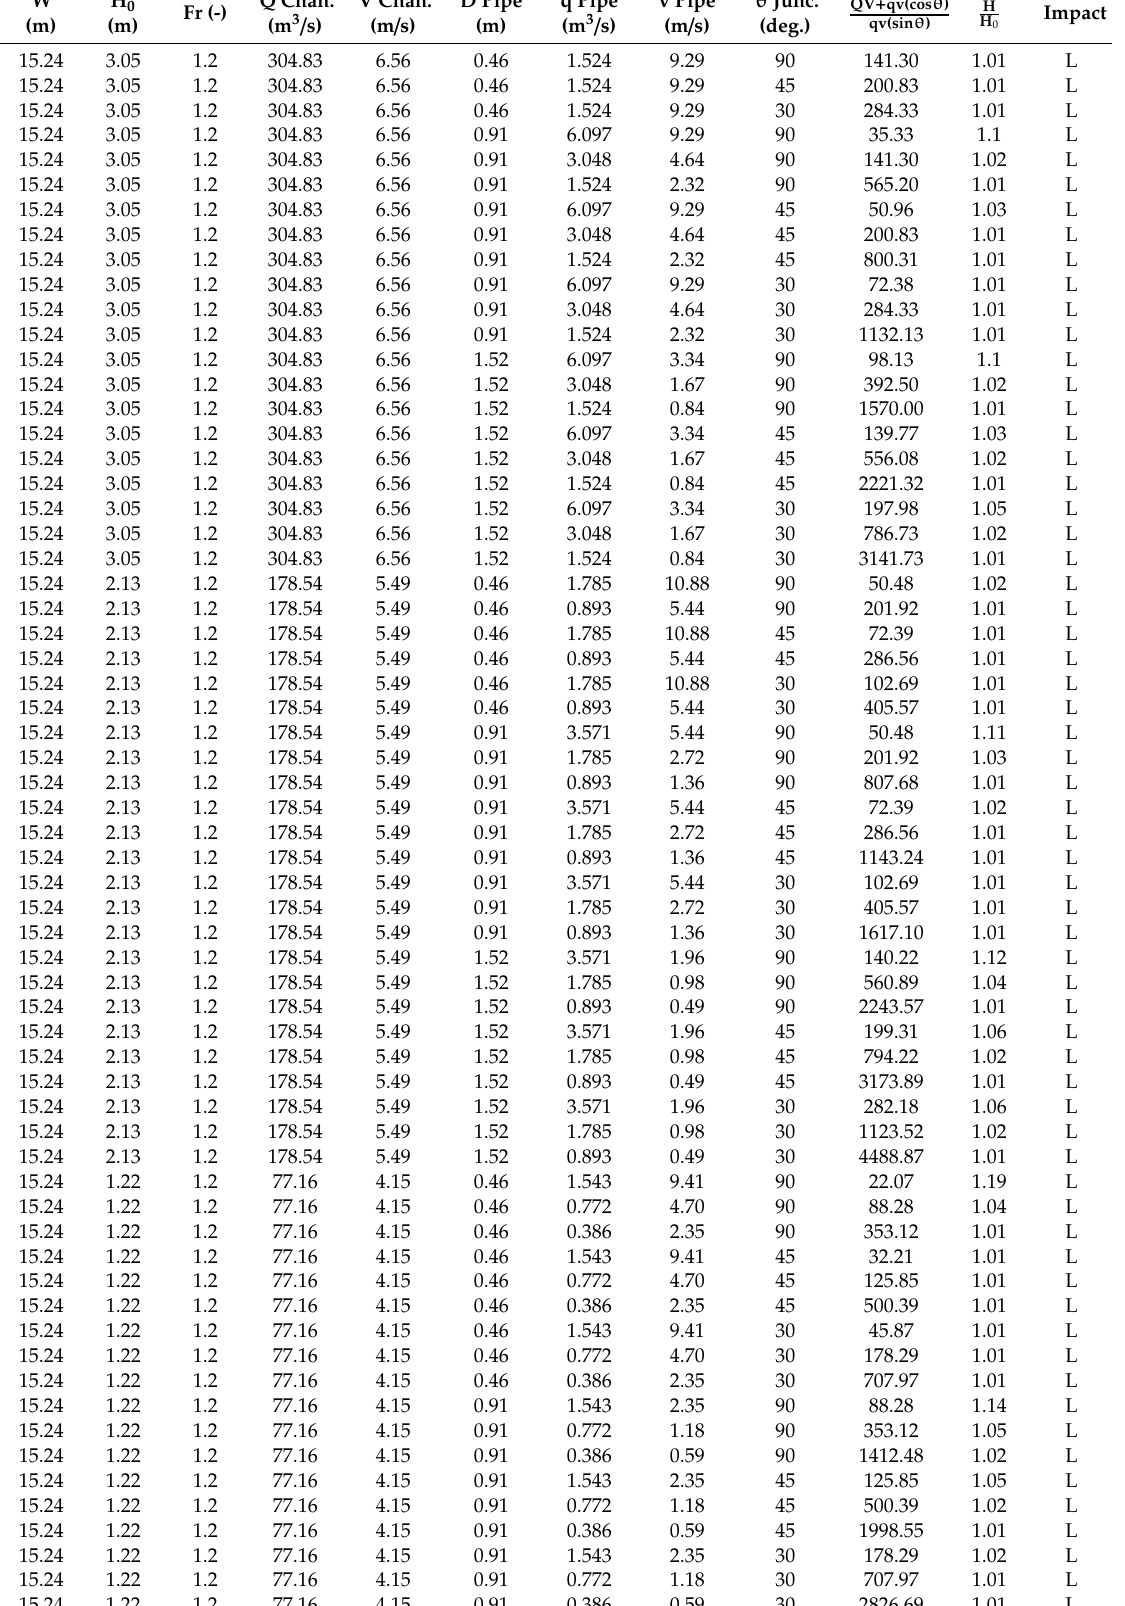
Table A6. FLOW-3D simulation results for W = 15.24 m (50 (cid:48) ) and Fr =